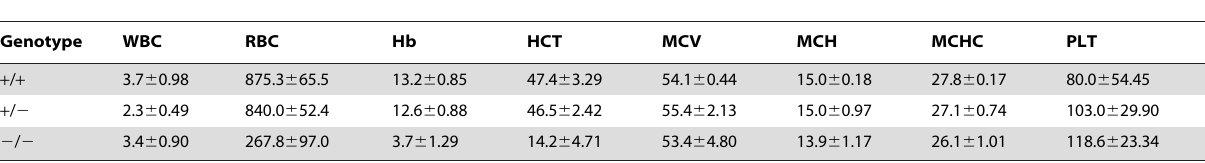
Table 2. Hematopoietic parameters of control and CALM 2 / 2 mice.